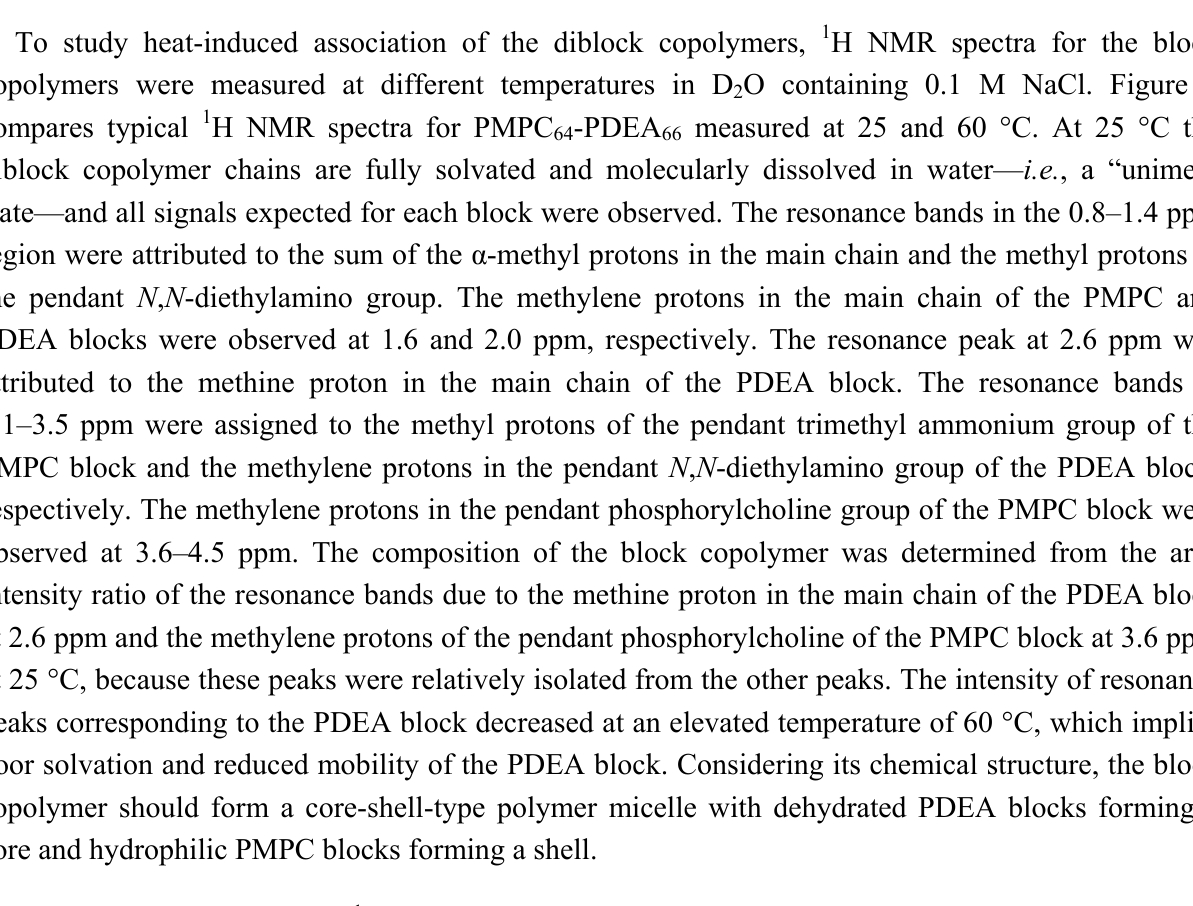
-PDEA at 25 °C ( a ) and 60 °C ( b ) in 64 66